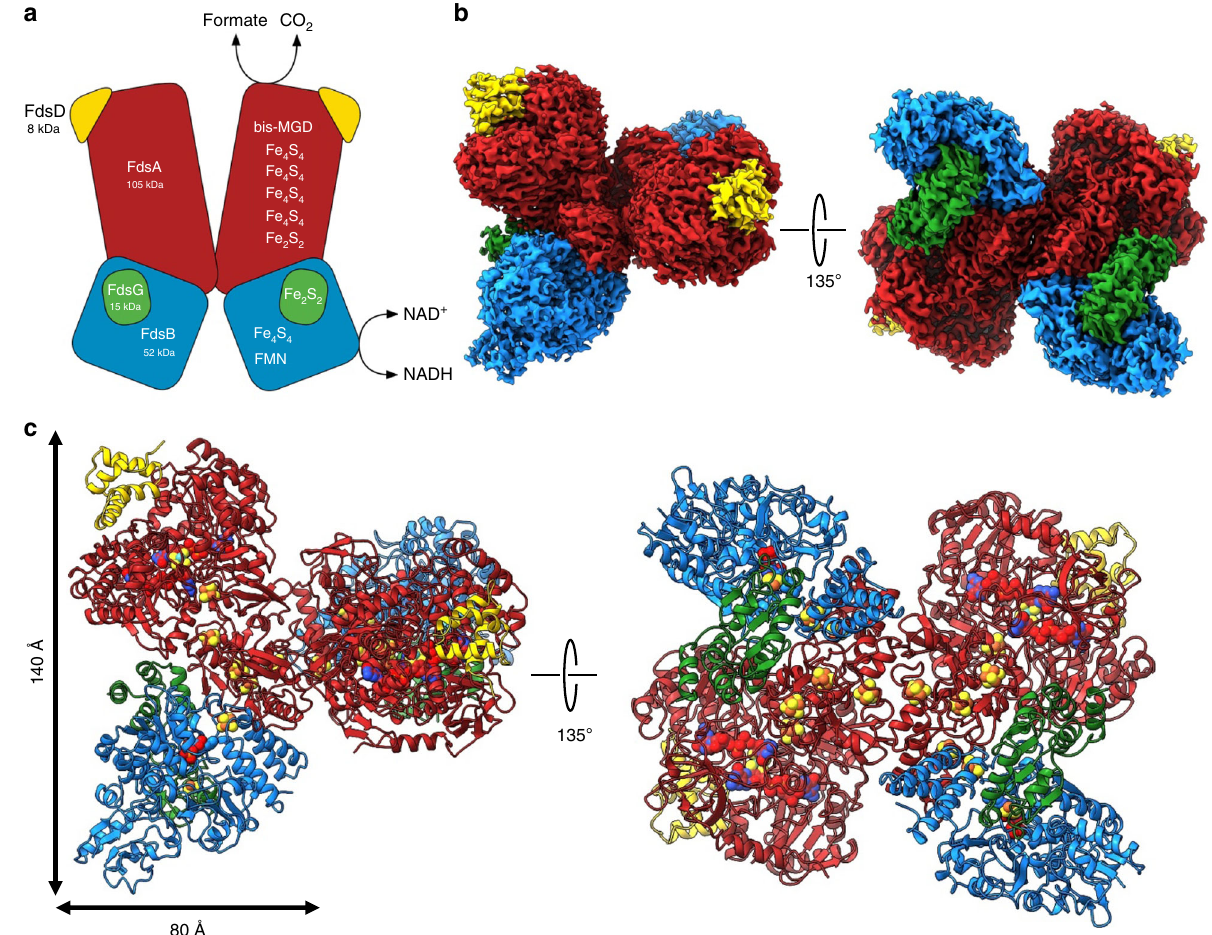
Fig. 1 Structural analysis of Rc FDH. a Schematic representation of RcFDH subunits. Cofactors are indicated. FdsA, red; FdsB, blue; FdsG, green; FdsD, yellow. b Three-dimensional reconstruction of C2 symmetric Rc FDH. The color code is as in a . c Ribbon representation of the atomic model derived from the EM structure. Cofactors are shown as